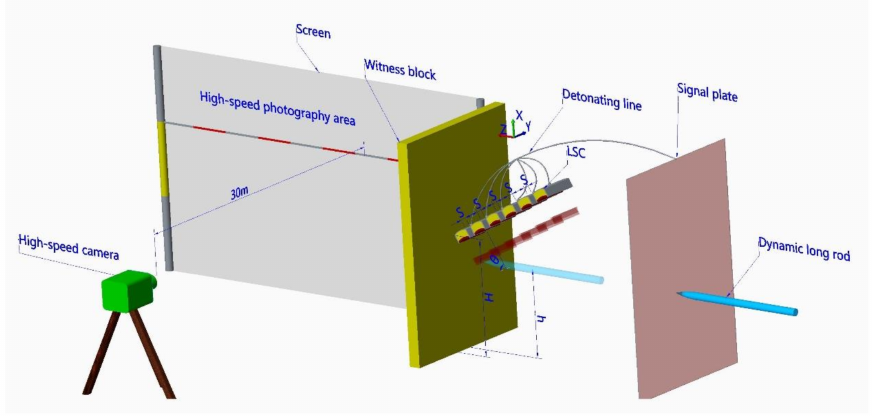
Figure 4. Schematic diagram of the dynamic test